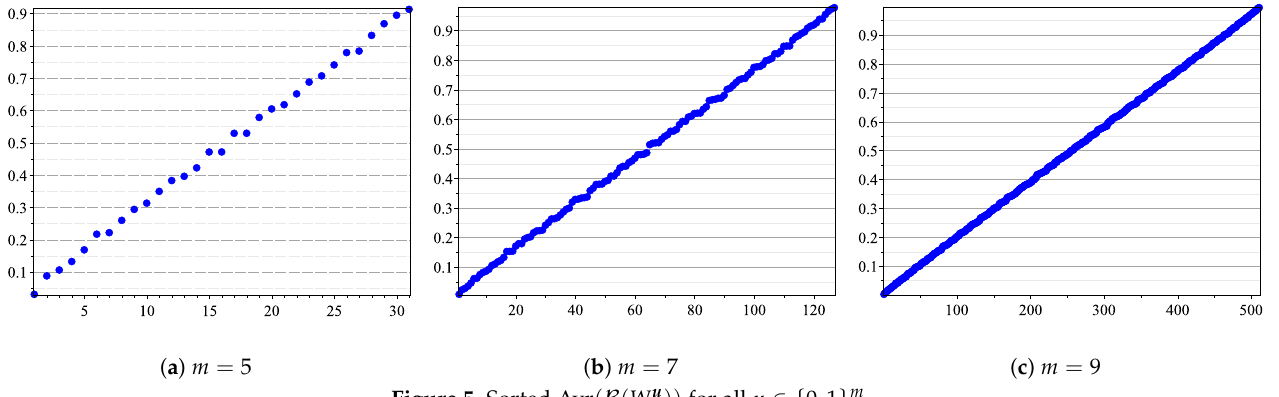
( W u )) for all u B m that satisfy Avr ( 0,1 ∈ { }